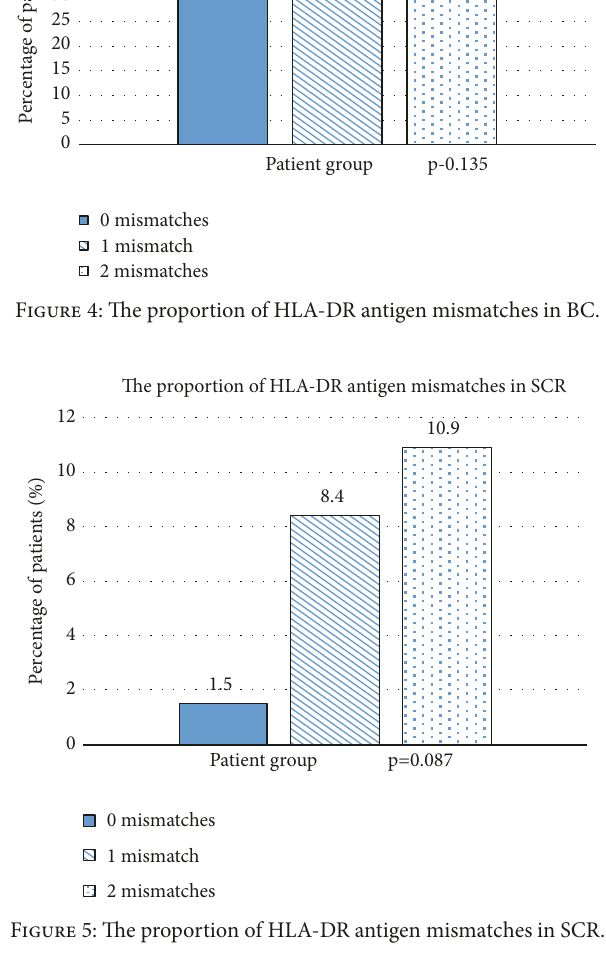
antimetabolite (mycophenolic acid or azathioprine), and